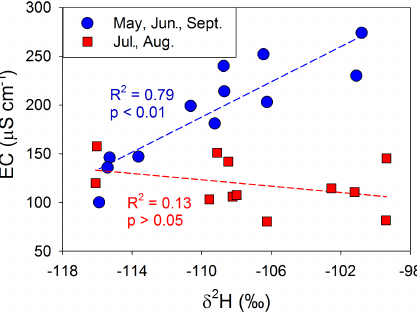
Figure 7. Relation between δ 2 H and EC of samples collected at S5-USG and S3-LSG on the same days in 2011, 2012 and 2013, grouped by